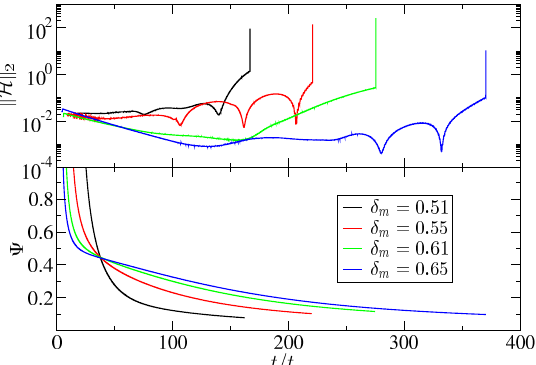
Figure 17. ( Top-panel ): Time evolution of the Hamiltonian constraint for different amplitude values δ m during the excision procedure. ( Bottom-panel ): Numerical evolution of Ψ in time. The crossing point is around t / t m ≈ 37.5. The profile used is the same as in Figure 16. The excision starts at very early times, at t ≈ 10 t m .